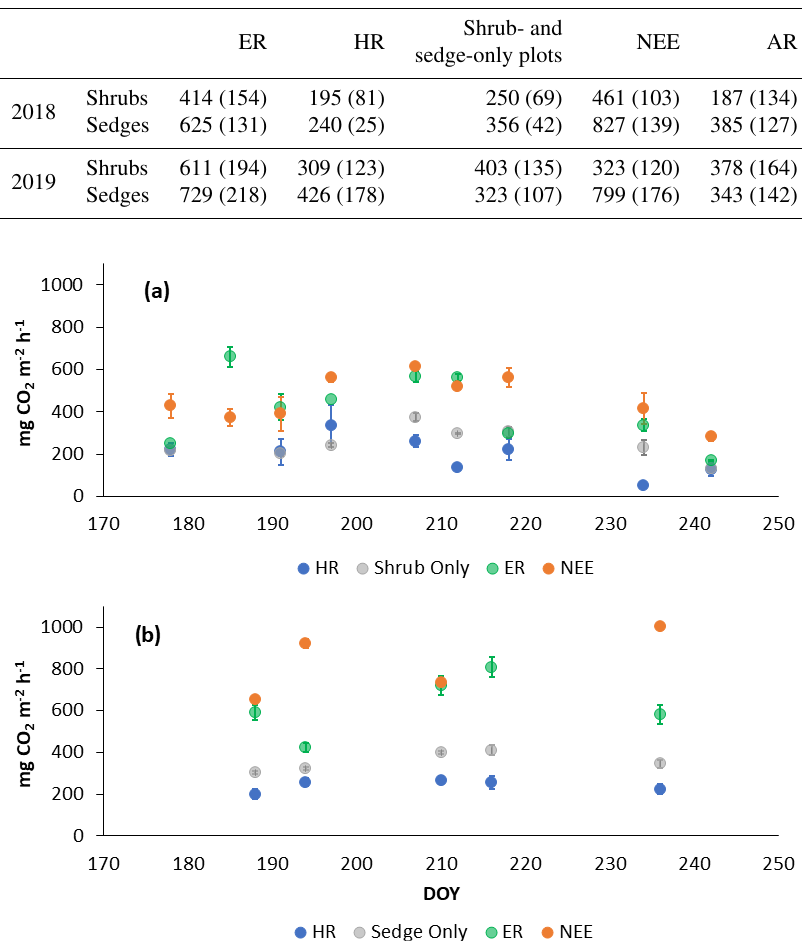
were higher than 2018 for the same air and soil temperature (Figs. 6 and